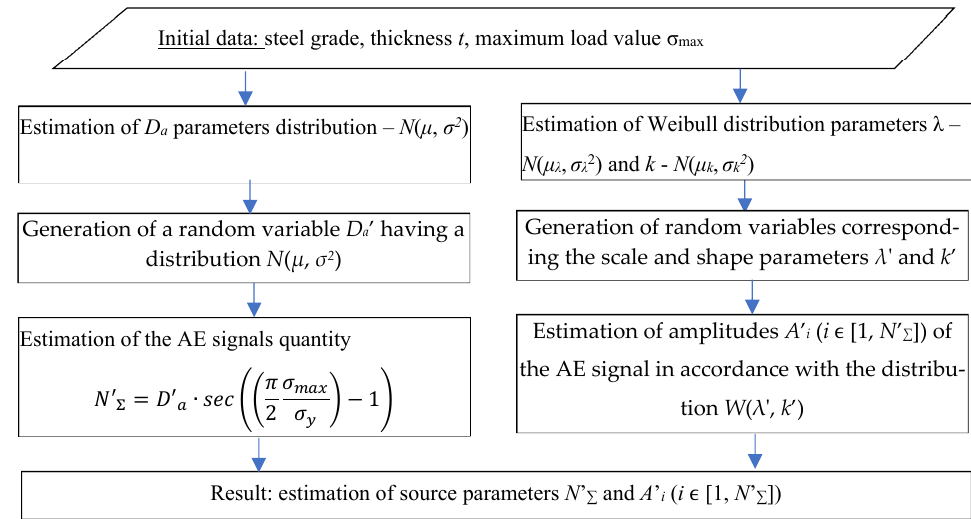
Figure 4. Flowchart of the algorithm for modeling the AE source parameters.